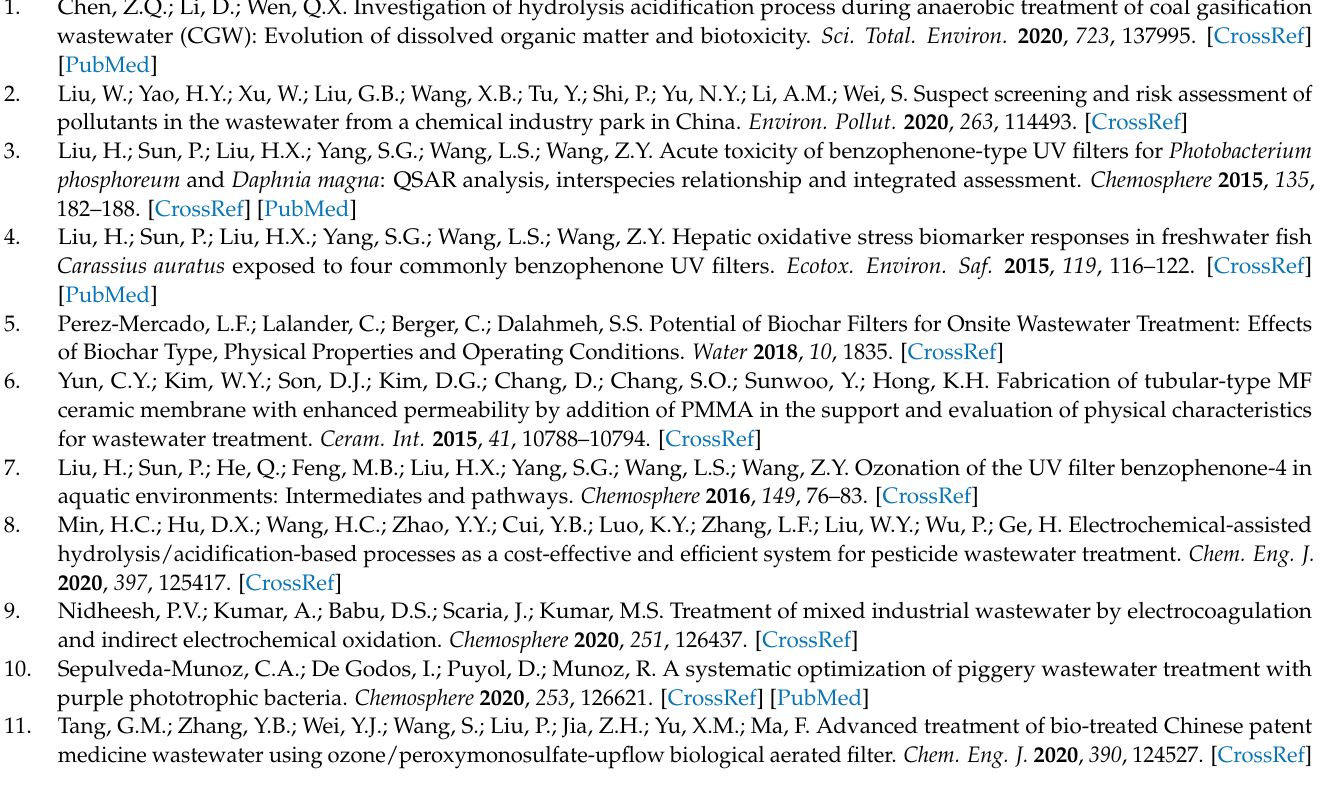
Figure S4: Degradation of the AO7 using different kinds of straw. Condition: [AO7] = 50